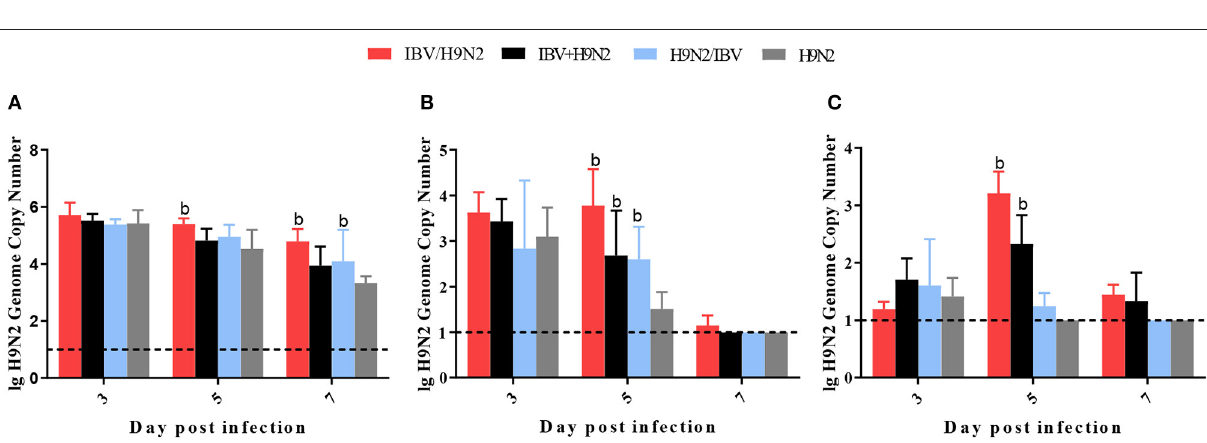
FIGURE 6 | Viral load of H9N2 virus in chickens. To compare virus replication, certain tissues, including samples from the trachea, lungs, and kidneys, were collected at 3, 5, and 7 dpi for virus titration using one-step RT-qPCR. (A) Trachea, (B) lungs, and (C) kidneys. Data are presented as means ± SD. “b” indicates a significant difference ( P < 0.05) between the three co-infection groups and the single-infection H9N2 group. Dashed black lines indicate the lower limit of detection. RT-qPCR, quantitative reverse transcription polymerase chain reaction; SD, standard